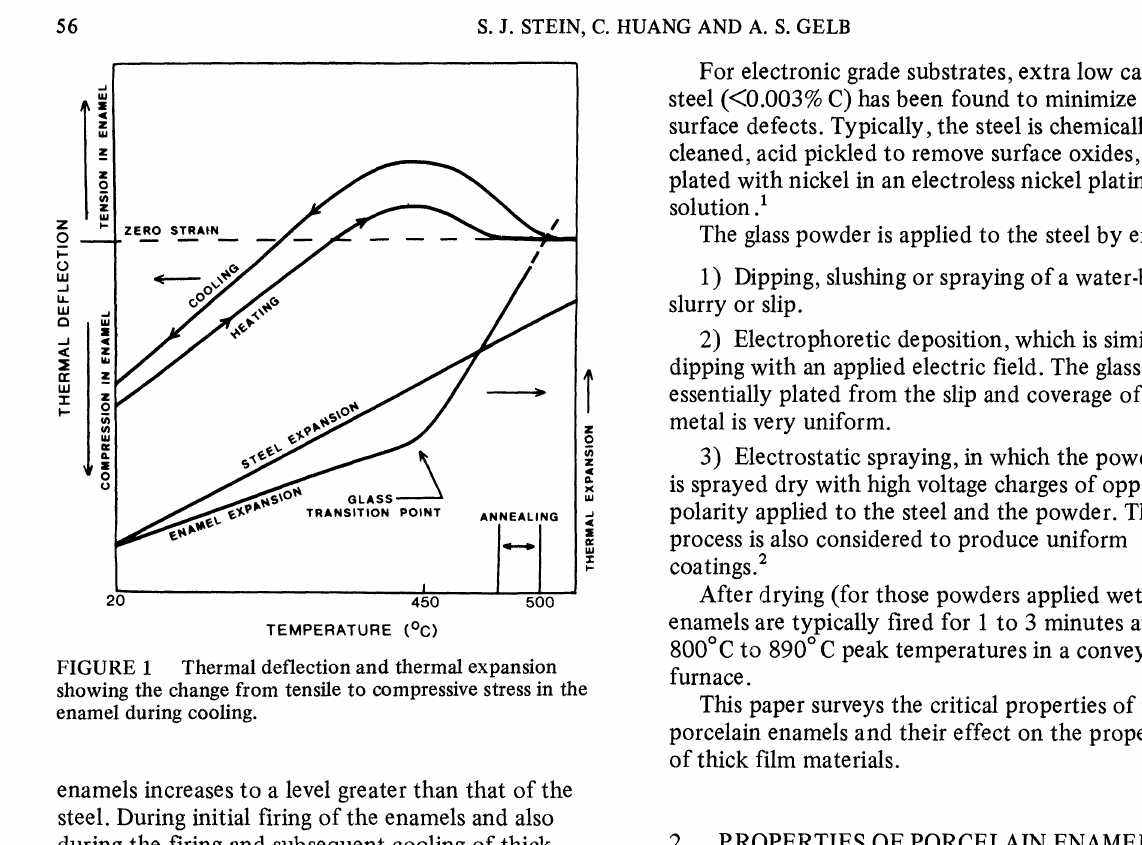
FIGURE Thermal deflection and thermal expansion showing the change from tensile to compressive stress in the enamel during